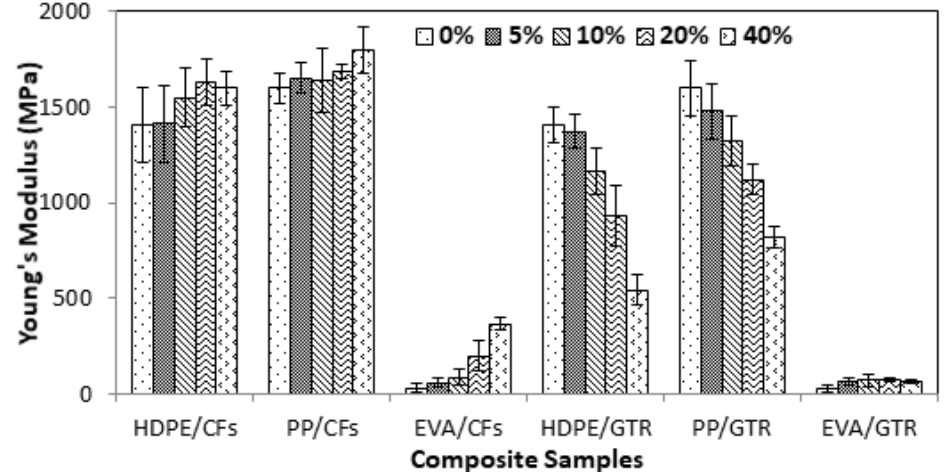
Figure 2. Young’s Modulus of the polymeric composites at compositions between 0 and 40% w / w .